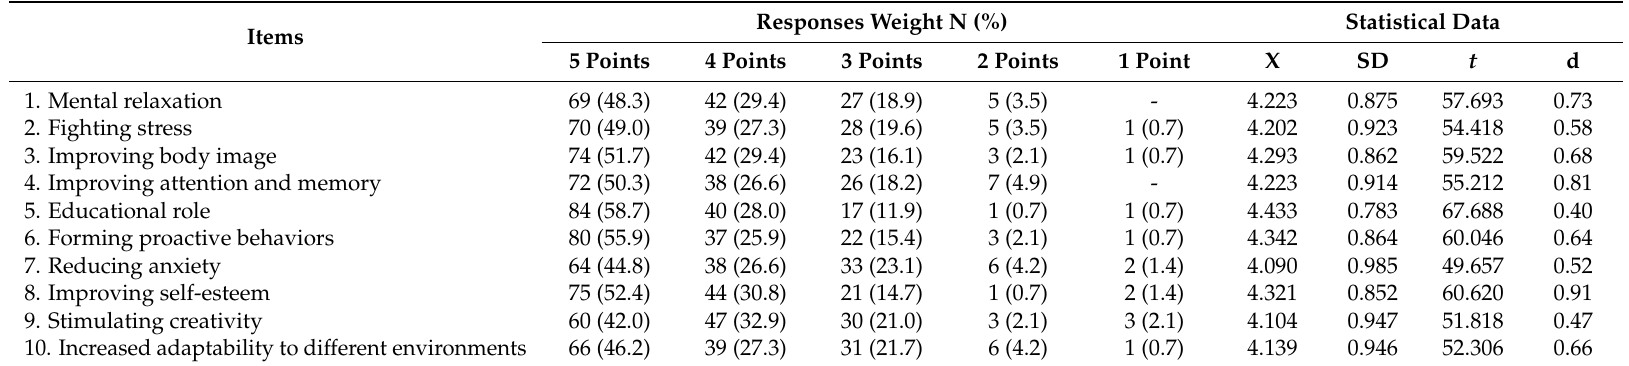
Table 2. Descriptive statistical of the mental part of the questionnaire of the benefits of practicing recreation figure